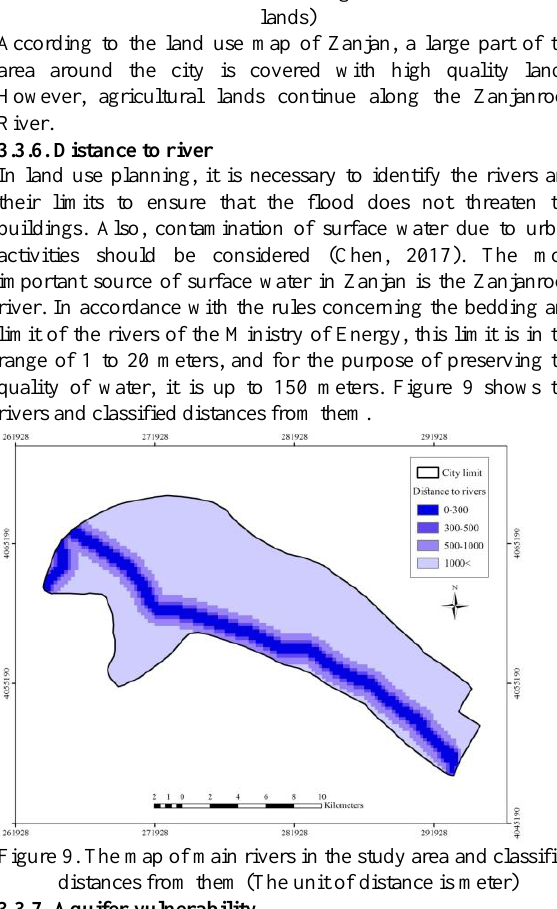
Figure 8- The land use map of the study area, The colour of units show the suitability of them for urban land use (The brown unit is the worst and the dark green unit shows the best lands)